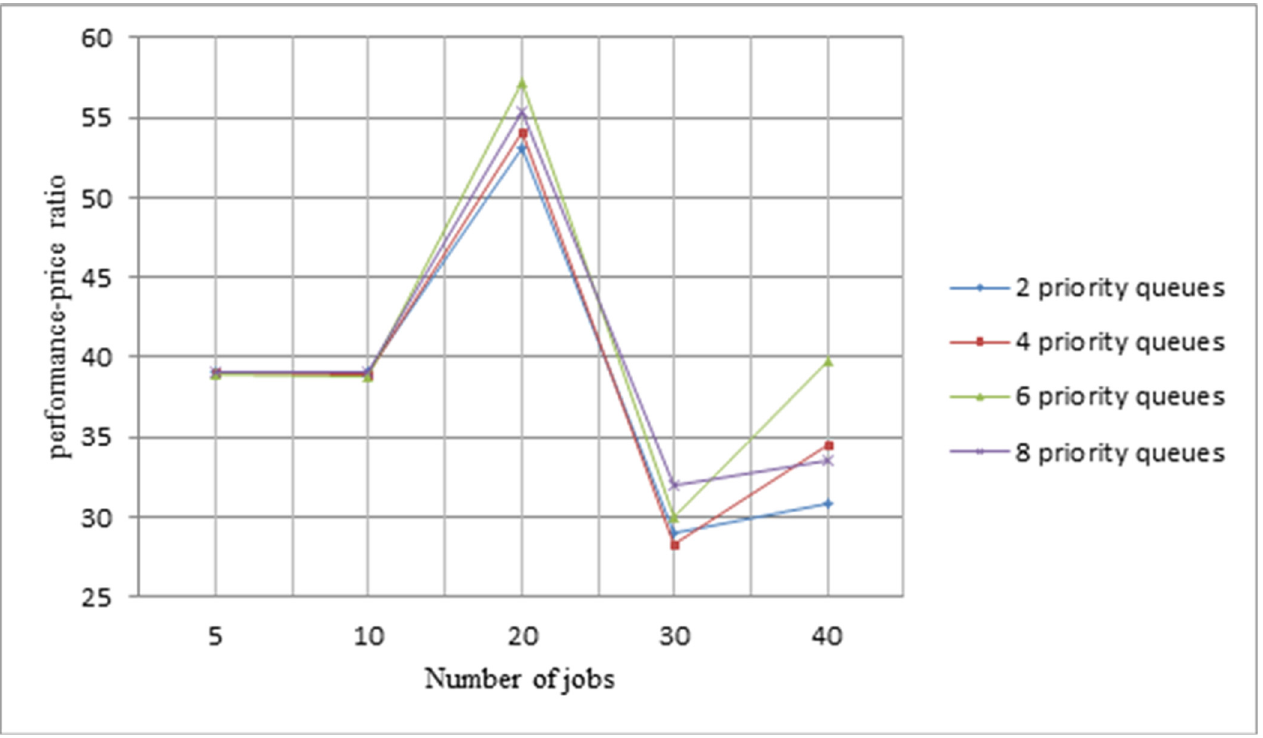
Fig 9. Selecting a suitable number for priority queues. Different numbers of jobs are displayed in x-axis, and y-axis presents the average performance-price ratio of jobs. On the right side, 2, 4, 6, 8 represents different numbers of priority